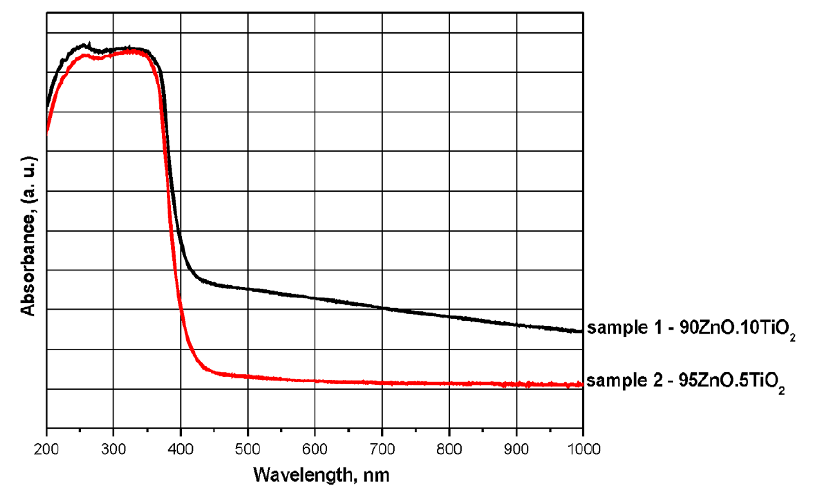
Figure 5. UV-Vis spectra of samples 1 and